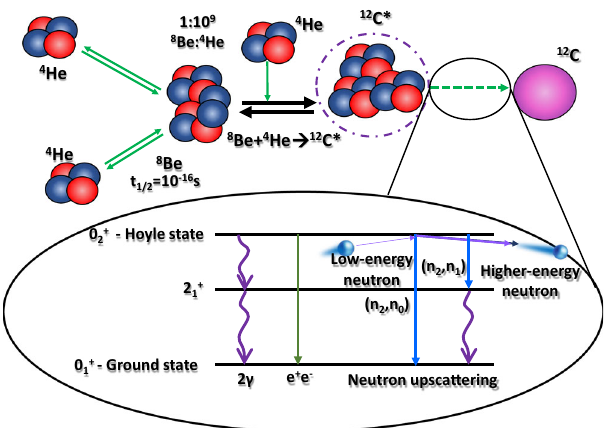
Fig. 1 Overview schematic diagram. This details the steps involved in the triple-alpha process, showing the contribution of neutron upscattering to the decay width to bound states. A low-energy neutron interacts with the Hoyle state leaving carbon-12 in the ground-state (or fi rst-excited state) and the extra energy is carried away with the